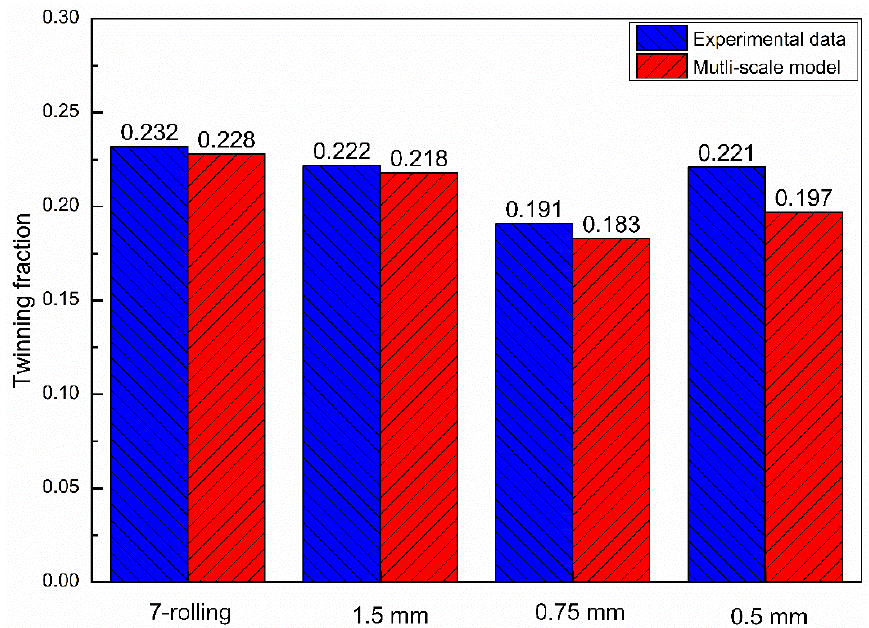
Figure 13. Comparison of twin-plane integral number of VPSC-simulated asymmetric rolling plate with that obtained from EBSD statistics.